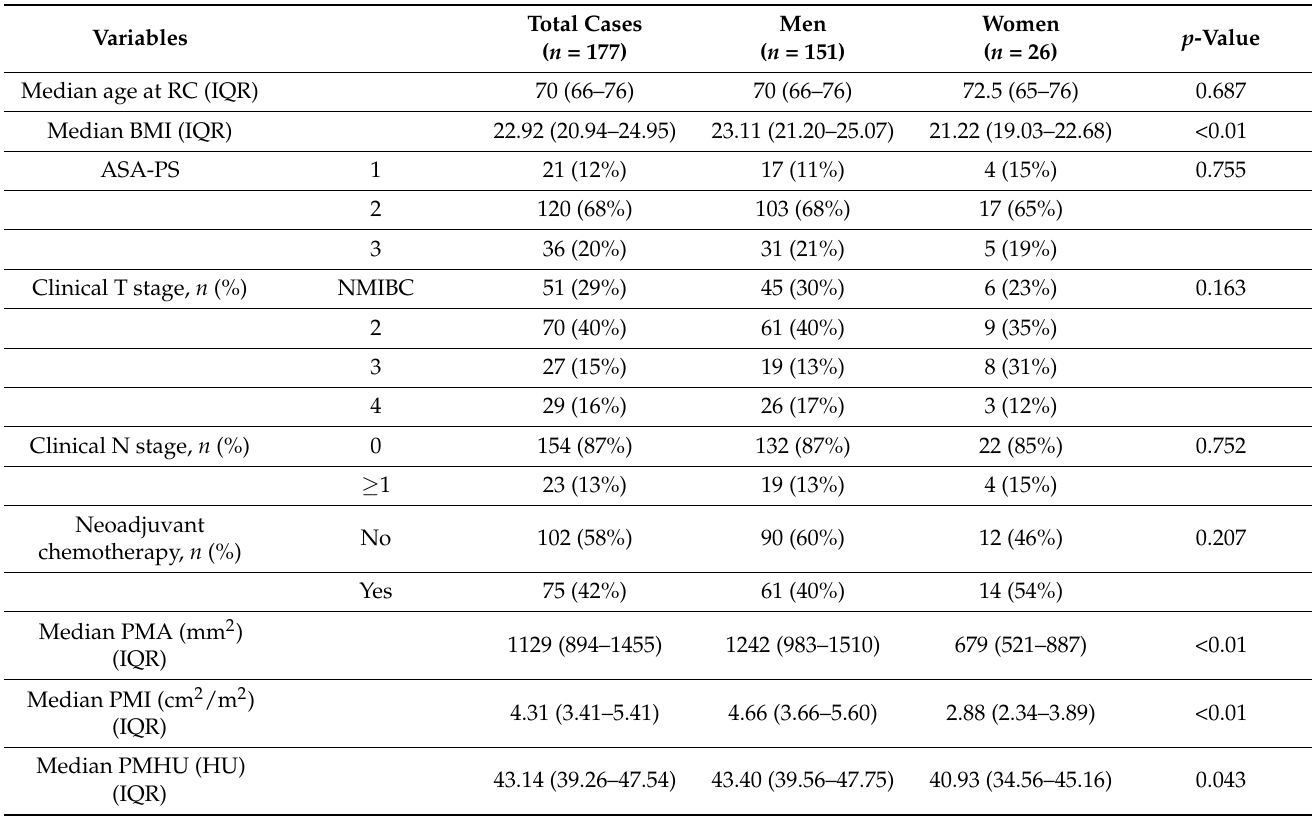
Table 1. Patient characteristics.